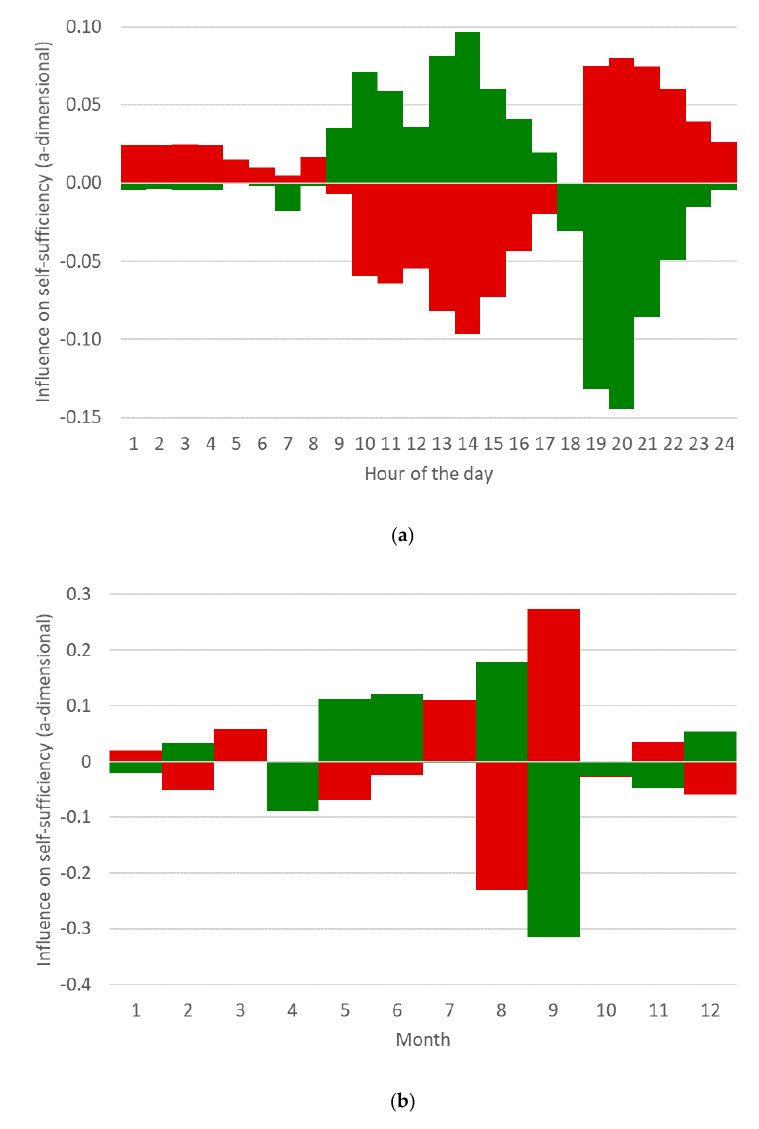
Figure 8 . Influence on self-sufficiency of high demand in: ( a ) each hour of an average day; and ( b ) each month of the year. The value is a-dimensional but it expresses the positive (or negative) influence of a high electric demand at a given time step compared to all the others (see Equation (3)). In practice, the curve is influenced only by the households that have a self-sufficiency above average. It represents the influence (positive or negative) that the demand in each time step has on the overall self-sufficiency. Unsurprisingly, Figure 8a shows that a lower average demand in the evening and early morning hours is associated with high self-sufficiency. On the contrary, the central hours of the day are generally above average in highly self-sufficient households. It is interesting to notice how the electric demand at 12:00 is in general less beneficial for self-sufficiency than the hours